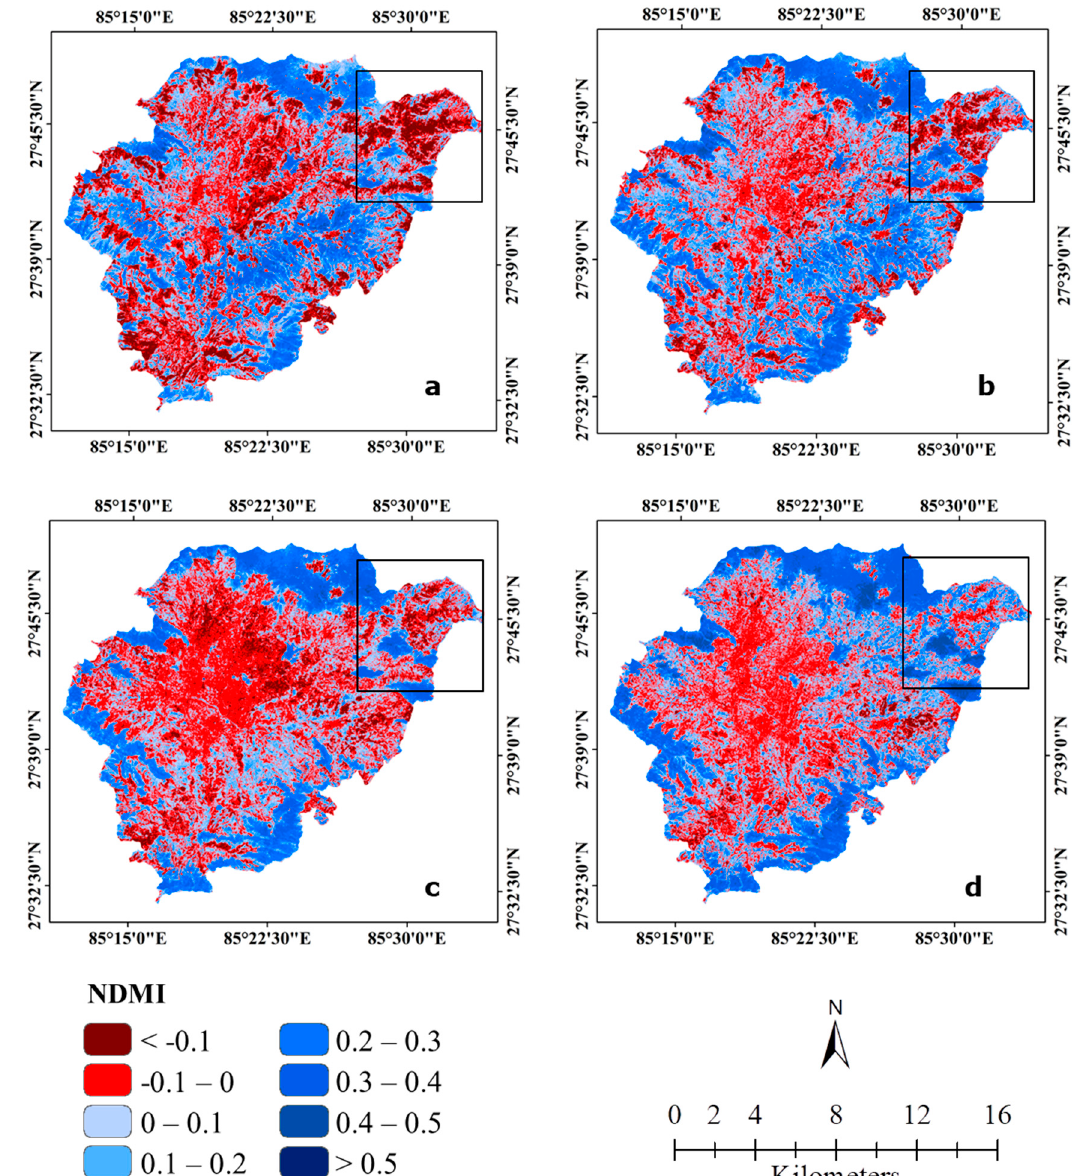
Figure 9. Spatial distribution of Normal Di ff erence Moisture Index (NDMI) in Kathmandu for, ( a ) 1988; ( b ) 1998; ( c ) 2008; ( d ) 2018. Square box transect over all Moisture Index maps ( a – d ) is to show the e ff ects of moisture index on LST.